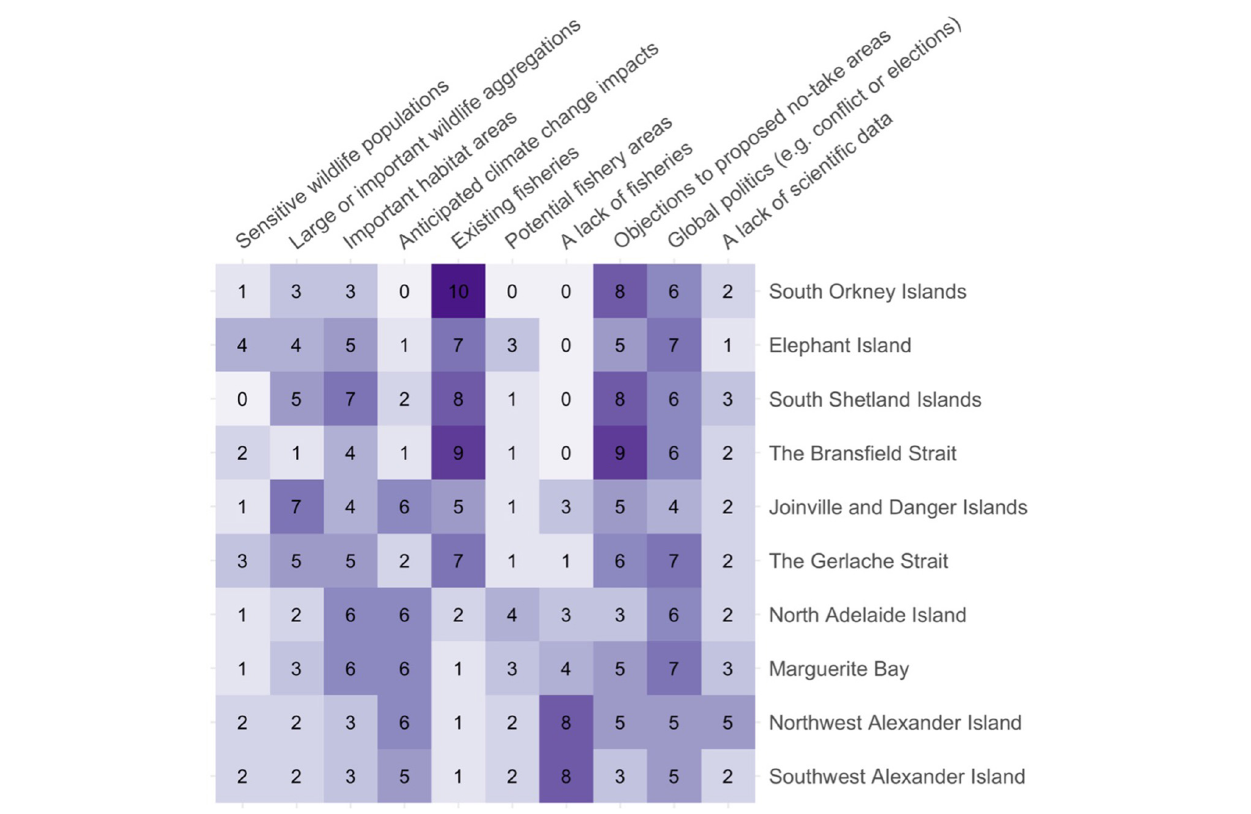
FIGURE 5 | A heatmap of the number of times factors were selected as being influential for each area under consideration. The y-axis is arranged latitudinally, north to south.